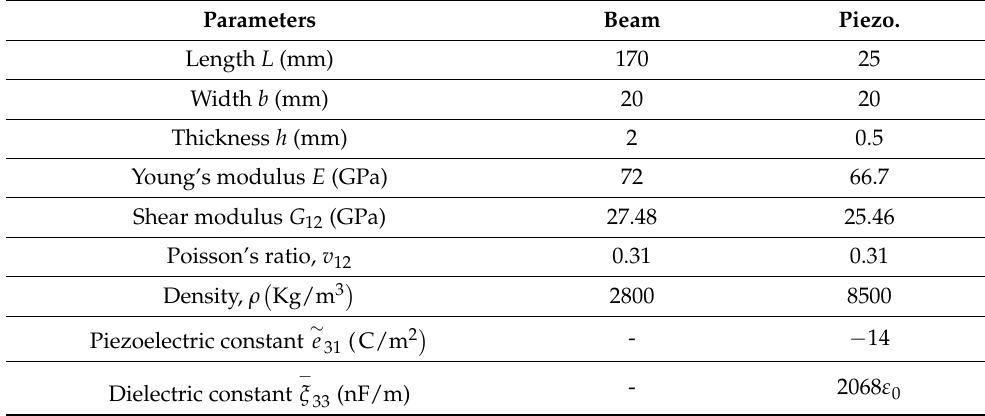
Table 1. Geometric and material parameters of the compound structure.